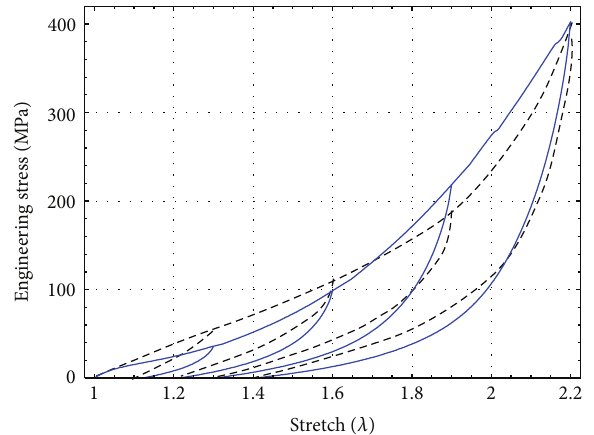
Figure 7: Engineering stress-stretch data for PGC25 3–0 sutures compared with theoretical predictions of the nonmonotonous amended average-stretch, full-network model for which 𝜇 = 90 MPa, 𝑁 = 2.35 , 𝑏 = 0.75 , and 𝐶 = 0.012 MPa. The dashed black lines represent theoretical predictions, and the blue solid lines describe experimental